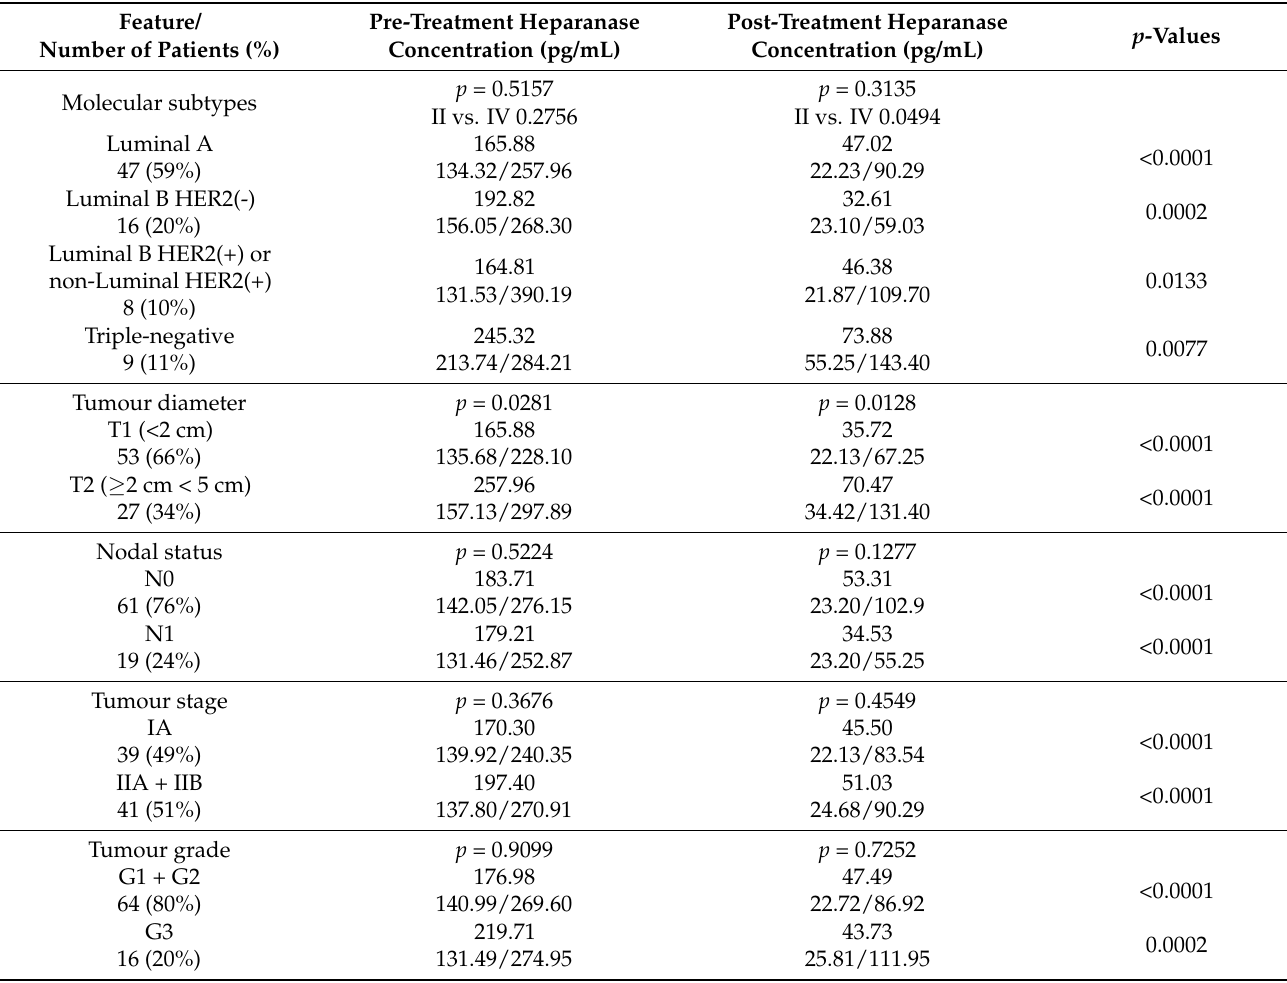
Table 3. The heparanase concentrations with respect to clinical and pathological characteristics in breast cancer subjects.